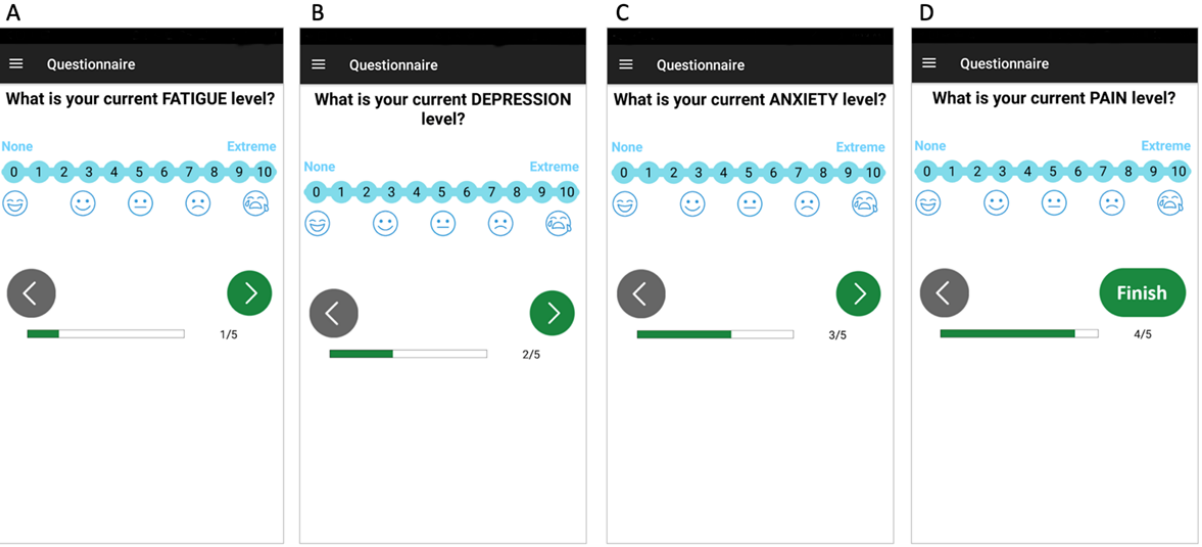
Figure 2. Sample screens for Visual Analogue Scales for fatigue (A), depression (B), anxiety (C), and pain (D). Users can freely navigate forward and backward between questions using the forward (green) and backward (gray) arrows at the bottom of the screen. Under the arrows, a status bar indicates the progress of the user in the Visual Analogue